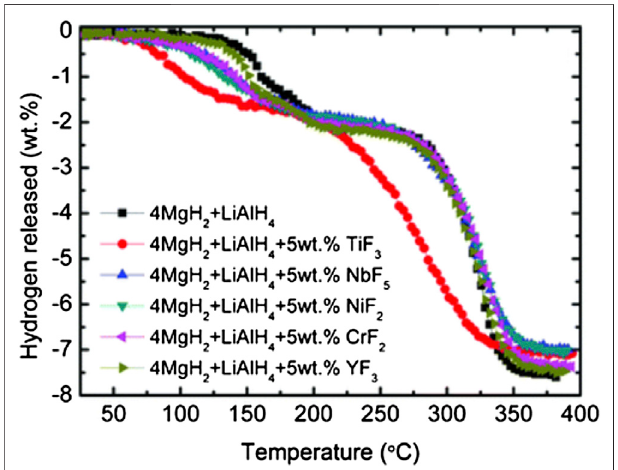
FIGURE 10 | Decomposition temperature results of the MgH 2 -LiAlH 4 composite with different selected metal halides (Ismail et al.,